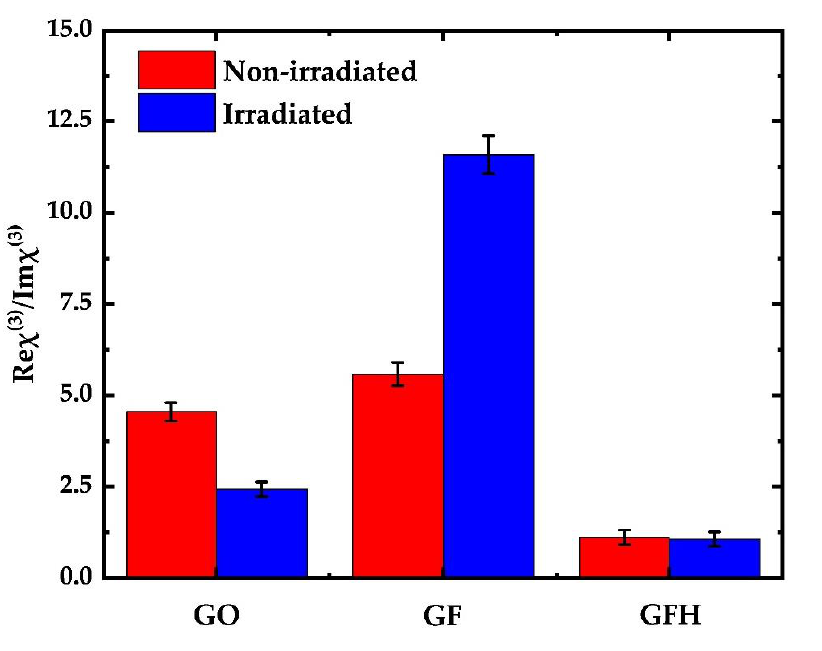
Figure 5. Variation in the Re χ (3) /Im χ (3) ratio for each sample before and after irradiation. Table 1. NLO parameters of G, GO, GF and GFH before and after UV irradiation. All values refer to a concentration of 1 mg mL − 1